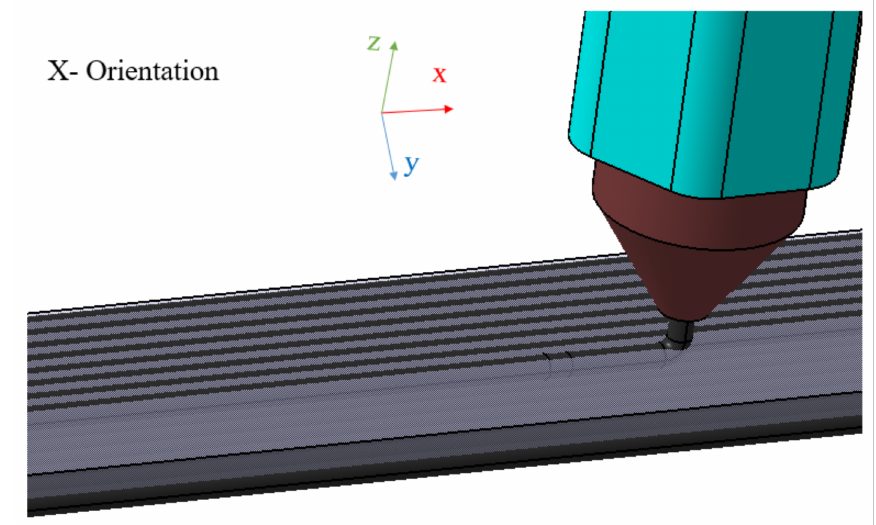
Figure 3. Schematic illustration of the specimen fabrication using an additive manufacturing technique.